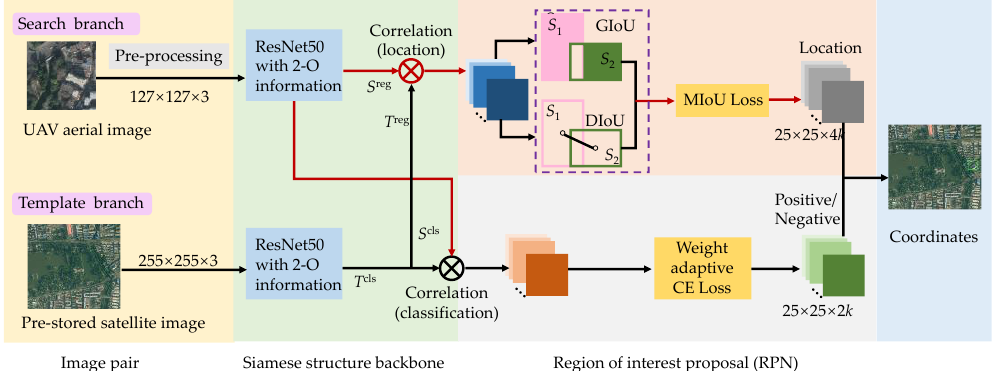
Figure 2. M-O SiamRPN with weight adaptive joint multiple intersection over union framework.